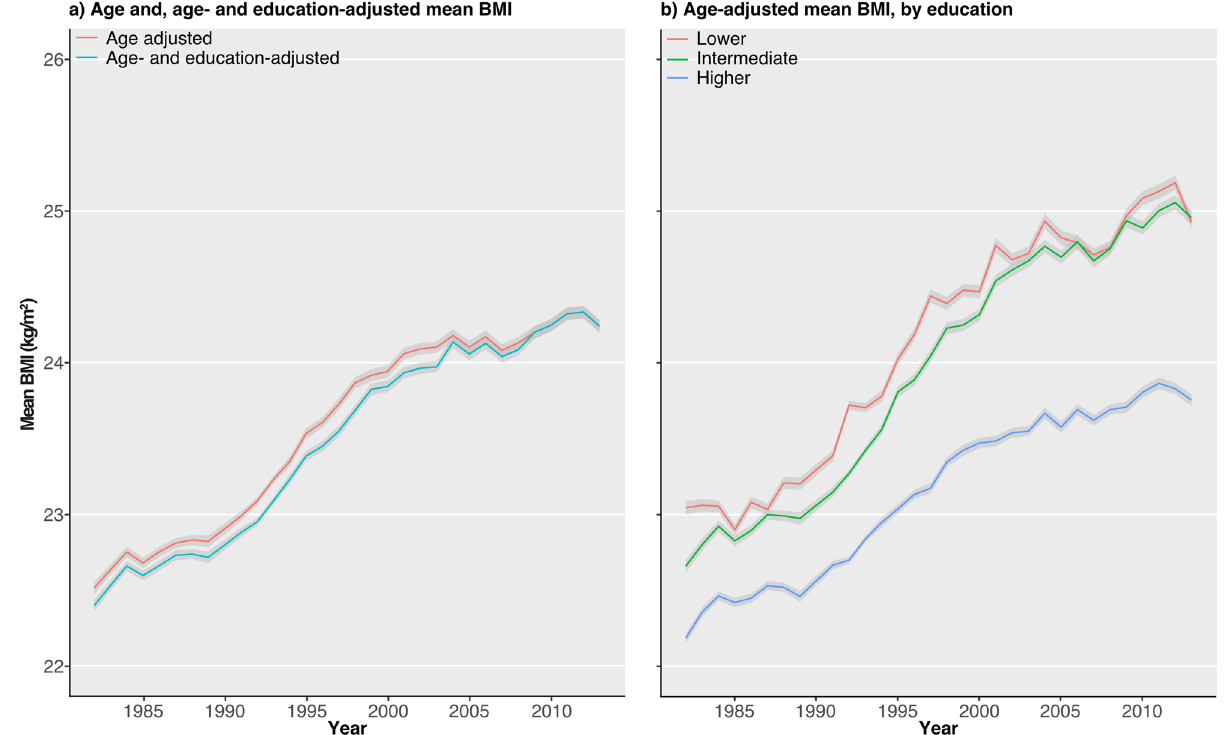
Figure 1. Trends in age-adjusted mean BMI. The lines show the yearly mean estimates and the shades show the 95% confidence intervals from 1982 to 2013. ( a ) Total cohort, age adjusted and age- and education adjusted, ( b ) by educational level adjusted for age. BMI body mass